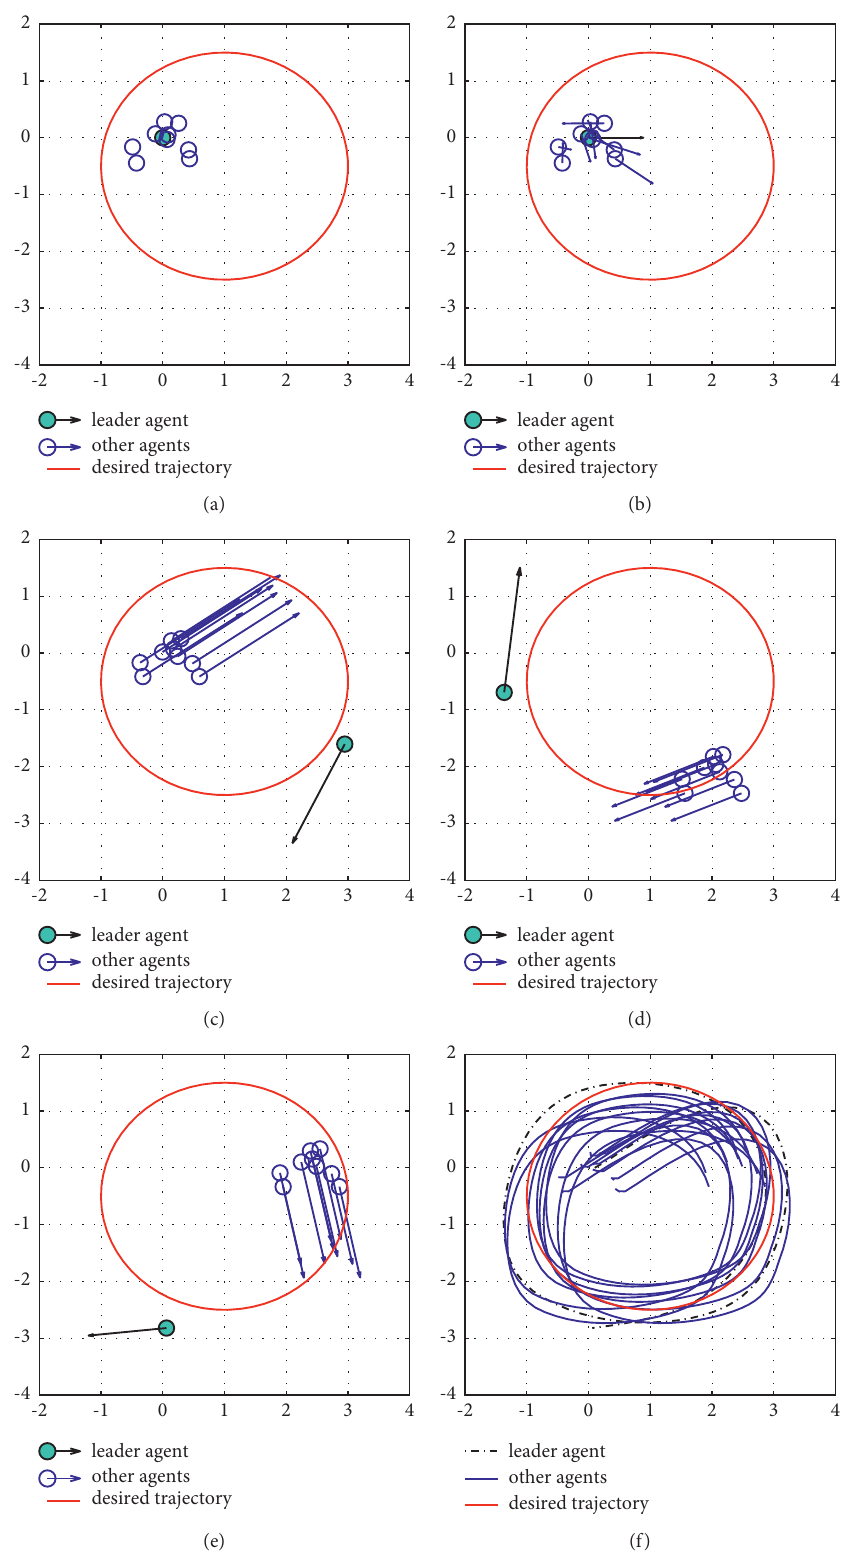
Figure 6: The movement of agents tracking the desired circular trajectory governed by leadership of delayed CS mode. Time delay is given by τ � 2 for t ∈ [ 0 , 10 ] . (a) Initial configuration. (b) t � 1. (c) t � 2. (d) t � 5. (e) t � 10. (f) t ∈ [ 0 , 10 ]